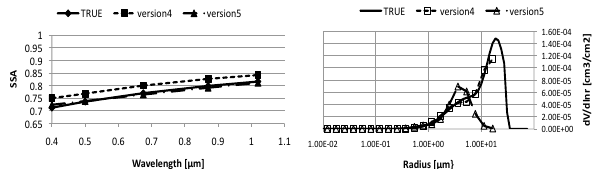
Fig. 7. Values of SSA (left panel) and SDF (right panel) for the enhanced coarse mode case. Solid, dashed, and dashed-dotted lines represent true values, retrieved values from version 4, and retrieved values from version 5, respectively.